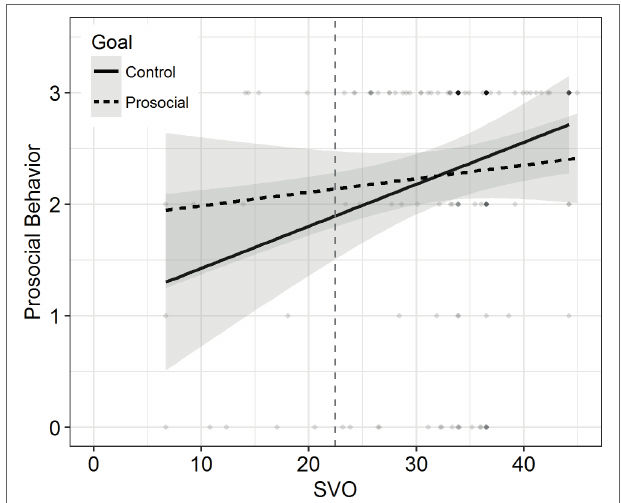
FIGURE 3 | Prosocial Behavior as a function of SVO in Study 2. Separate lines refer to the two conditions. Shades depict 95% CIs. Higher density of the scatter signifies higher concentration of data. Vertical dashed line separates proselfs (left) from prosocials